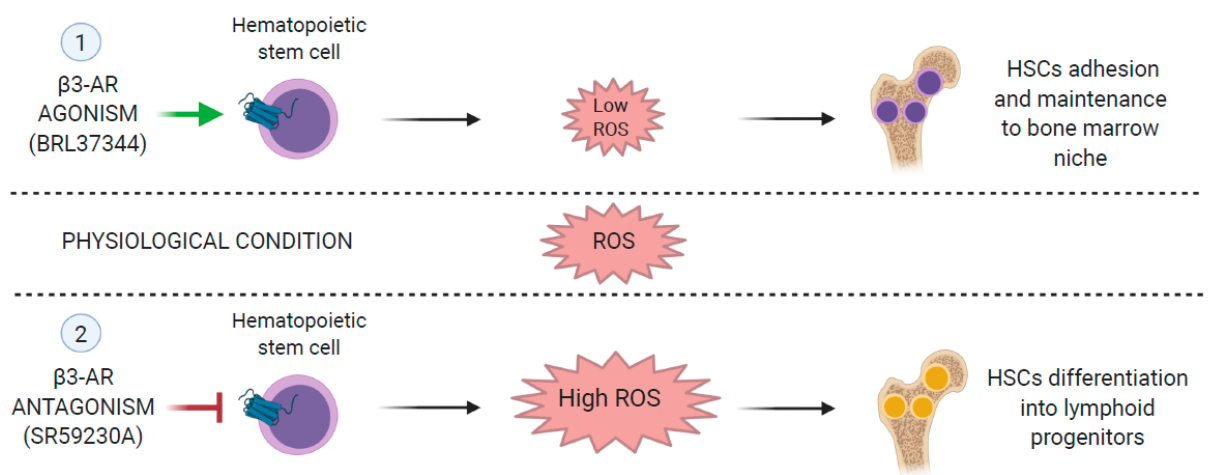
Figure 2. Effects of β 3-adrenoreceptors (Ars) agonists/antagonists on ROS levels and hematopoietic stem cells (HSCs) differentiation.